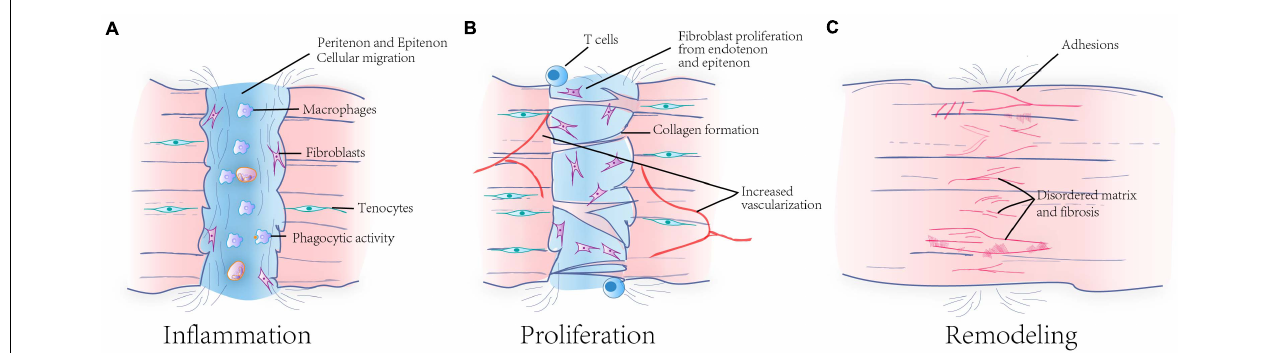
FIGURE 2 | Three phases of tendon healing and the matrix changes during the healing process. Tendon healing goes through three phases, including inflammation (A) , proliferation (B) , and remodeling (C) . In the inflammation phase, immune cells and fibroblasts from peritenon and epitenon migrate into injured position. In the proliferation phase, fibroblasts proliferate and angiogenesis occurs in this time. In the remodeling phase, repaired tendon has disordered matrix. The injured tendon finally forms tendon fibrosis and adhesion.